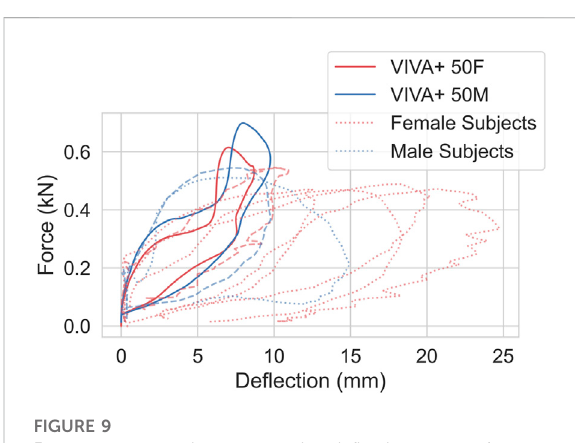
FIGURE 9 Force versus acromion-to-acromion de fl ection curves of shoulder impactat1.5 m/scompared with experimentaldata from Compigne et al., 2004. Dashed/dotted lines show experimental responses, red color represents females and blue represents males. The experimental PMHS responses close to the model responseareshownindashedlineforcomparison(reddashedline representsfemalesubject#3andbluedashedlinerepresentsmale subject #5).